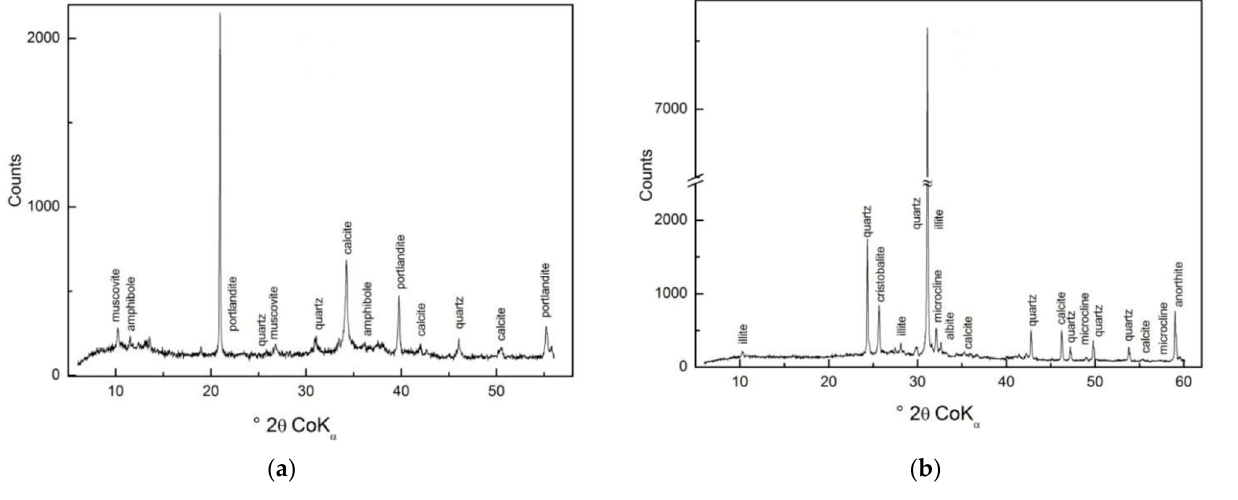
Figure 1. XRD patterns of WBS: ( a ) B; ( b ) TS. Table 1. Chemical and surface properties of B/B Fe and TS/TS Fe .